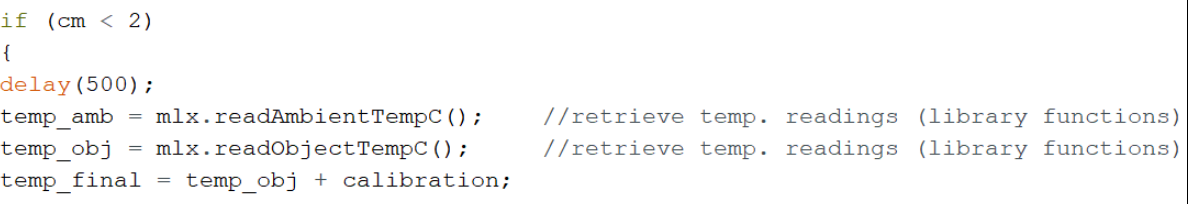
Figure 8. Library functions to retrieve body temperature readings.